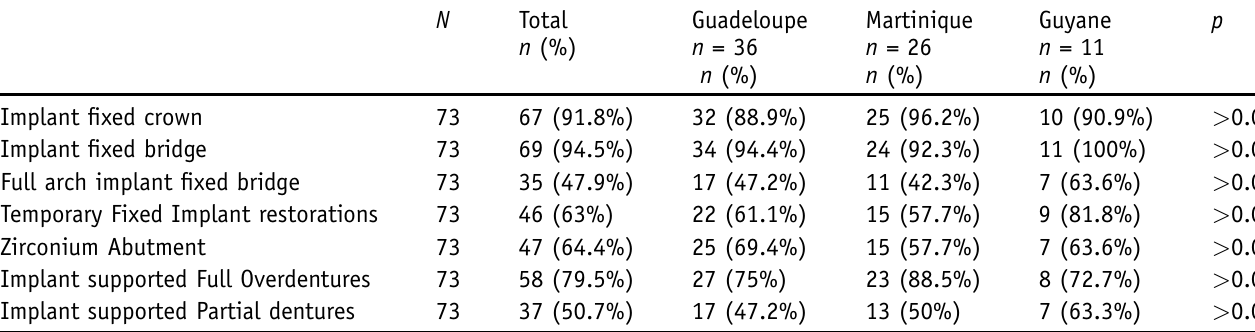
Table 5. Dental implant prosthetic procedures of dentists in Guadeloupe, Martinique and French